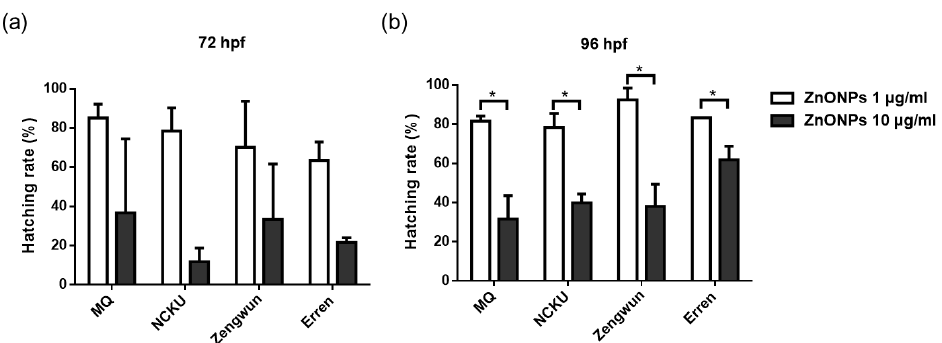
Figure 5. Developmental toxicity of ZnONPs. Hatching rate of zebrafish embryos exposed to ZnONPs. ZnONPs spiked in NCKU Lake, Zengwun Reservoir, and Erren River water. Hatching rate at ( a ) 72 hpf and ( b ) 96 hpf after exposure to different natural water samples. ZnONPs spiked in different water samples resulted in later hatching times in all groups. The significance between each different concentration groups were represented by * sign. (* p < 0.05). ZnONPs, zinc oxide